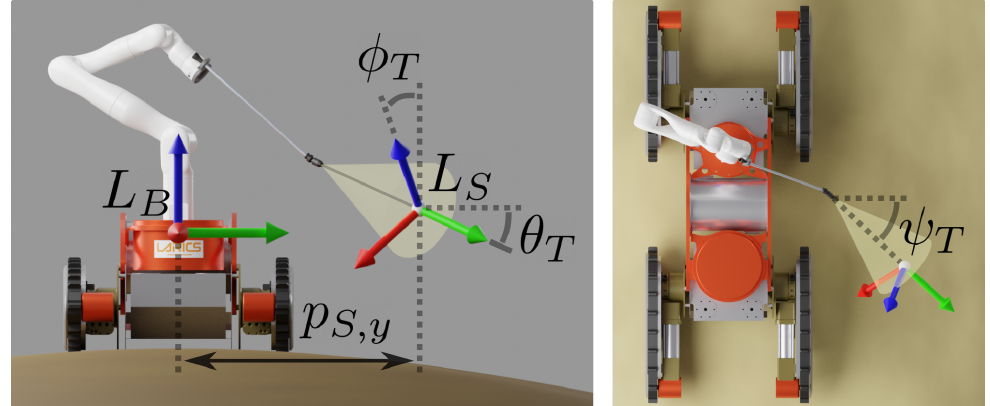
Figure 6. The orientation of the spray frame depends on the joint configuration of the robot arm. Roll, pitch and yaw angles are referred to as φ T , θ T and ψ T ,